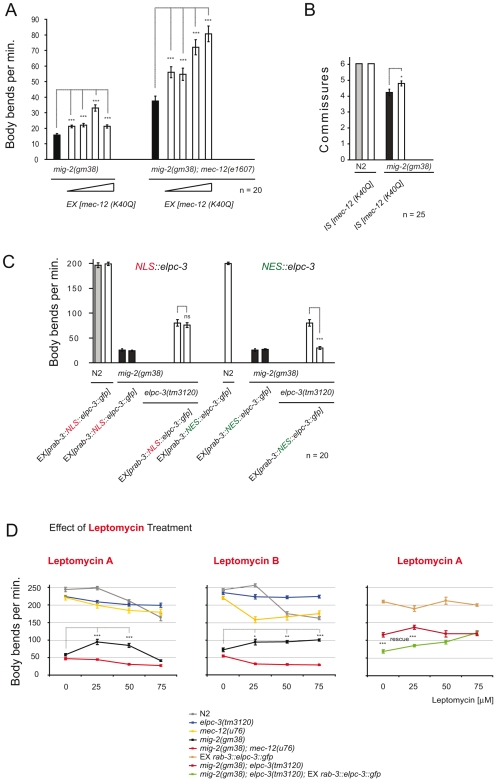
Effects of mec-12/α-tubulin[K40Q] and cytoplasmic requirement of ELPC-3.(A) mig-2(gm38) or mig-2gm38);mec-12(e1607) animals were injected with 3ng/µl of the gfp::mec-12[K40] construct. The transgene suppresses the movement phenotypes of both genetic backgrounds. 4 different lines with increasing gfp signal were tested. (B) Expression gfp::mec-12[K40] suppresses the defects in commissures of mig-2(gm38). (C) Expression of NES::elpc-3 (nuclear export signal) but not NLS::elpc-3 (nuclear localization signal) rescues the suppression in mig-2(gm38);elpc-3(tm3120) double mutants. (D) Leptomycin treatment of worms with different genetic backgrounds. Leptomycin A and B suppress the movement defects of mig-2(gm38). The suppression is dependent on mec-12, since mig-2(gm38);mec-12(u76) cannot be suppressed. Rescue of the suppression in the mig-2(gm38); elpc-3(tm3120) EX [elpc-3::gfp], is abolished at high concentrations of Leptomycin A. P values: ns = not significant; *<0,05; **<0,01; ***<0,001. Error bars: SEM.